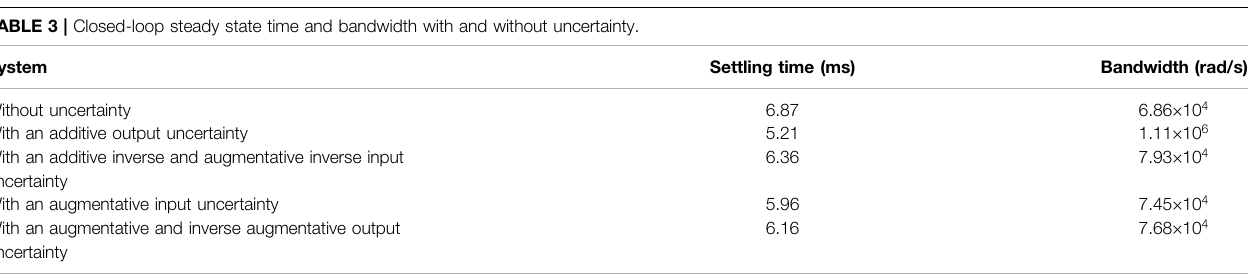
TABLE 3 | Closed-loop steady state time and bandwidth with and without